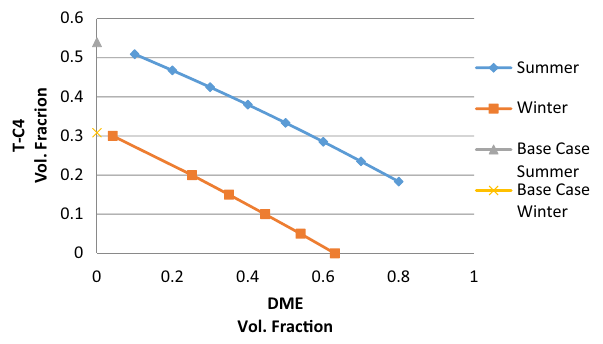
Fig. 20 Effect of adding DME on LPG T-C4